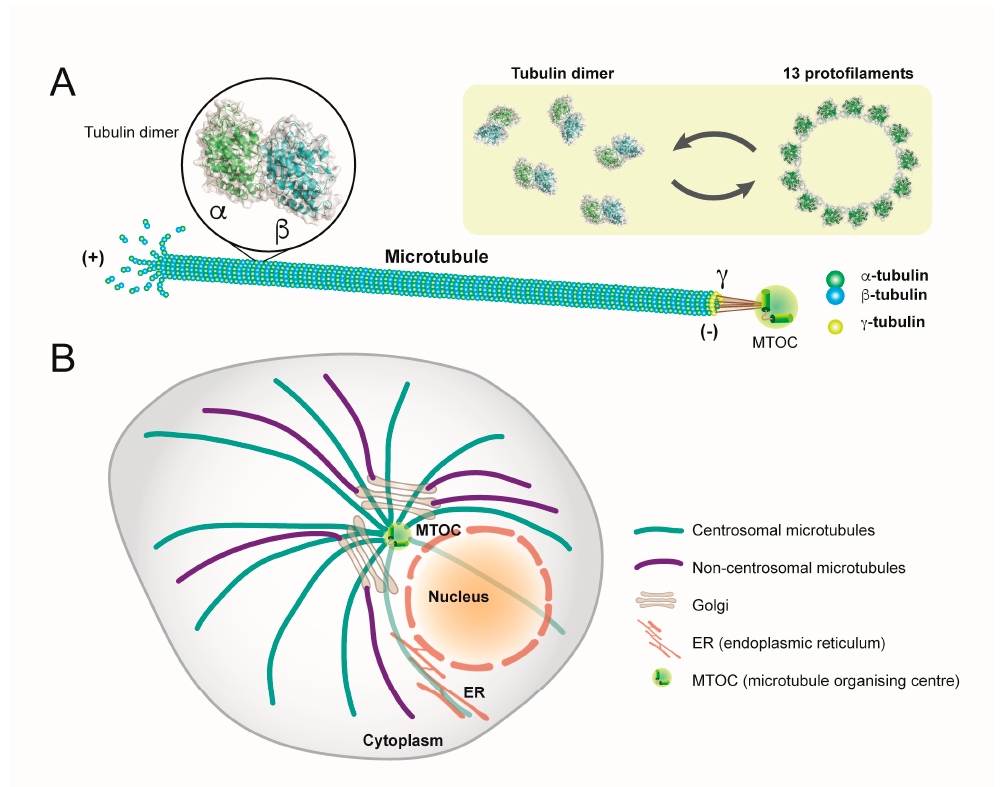
Figure 1. Structure and organisation of microtubules. ( A ) Microtubule filaments are comprised of multiple dimeric complexes of α - and β -tubulin, assembled around a hollow core. Thirteen protofilaments assemble to form a microtubule. Microtubules are anchored at their minus ends at MTOCs, which is mediated by γ -tubulin. ( B ) Microtubules form dynamic networks in the cytoplasm which are stably anchored at MTOCs, including the centrosome and Golgi apparatus. Three-dimensional structural data: PDB ID tubulin dimer (1TUB).